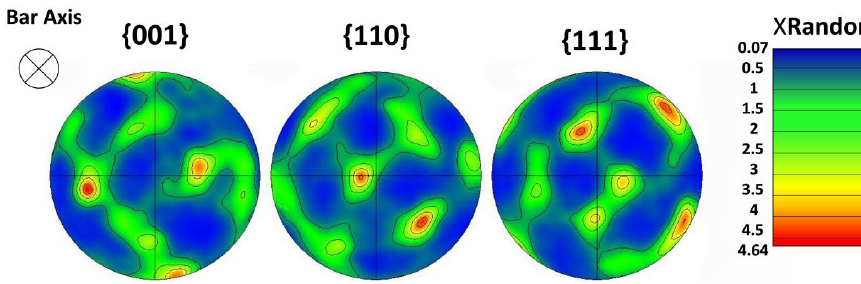
Figure 5. The pole figure of UFG 6061AA.